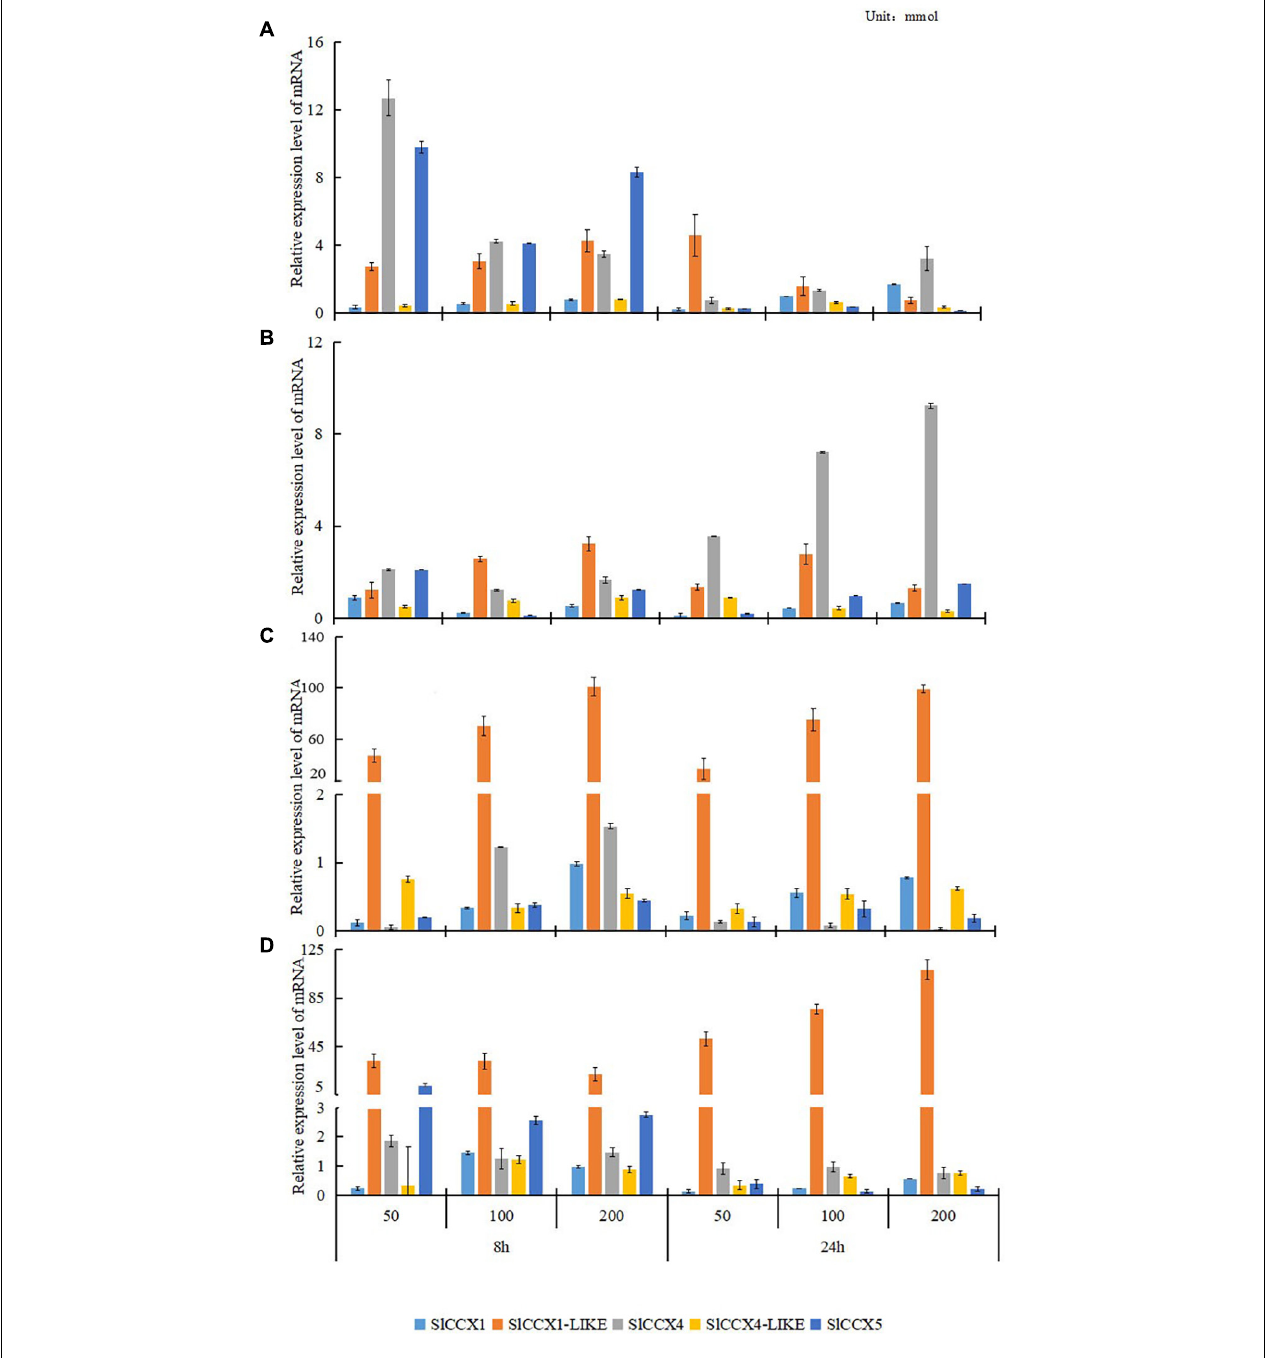
FIGURE 6 | The expression of SlCCXs under different cation concentrations treatments in mature-green fruits. (A–D) Different ion treatments: (A) NaCl; (B) CaCl 2 ; (C) MgCl 2 ; and (D) MnCl 2 . The treatment concentration of each ion was 50, 100, and 200 mM. The treatment time was 8 and 24 h. Bar represents the corrected standard and error. Data were normalized to ACTIN gene expression, and values of relative expression data of untreatment control (0 h, 0 mM) was normalized to 1.